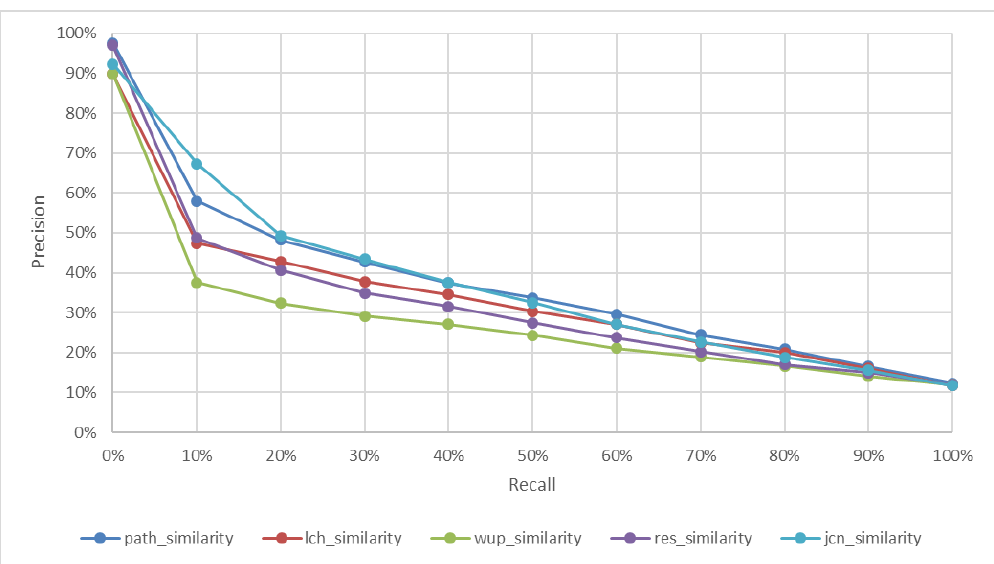
Figure 11. Precision-Recall Curve for Textual Semantic Similarity Measures.